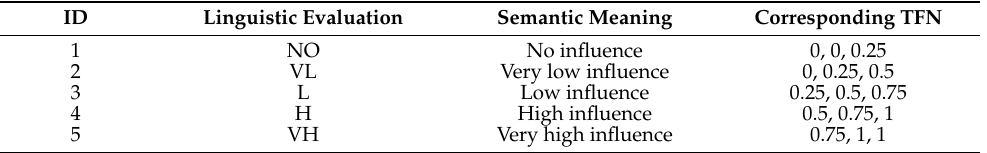
Table 2. Adopted evaluation scale translating linguistic evaluations to TFN.